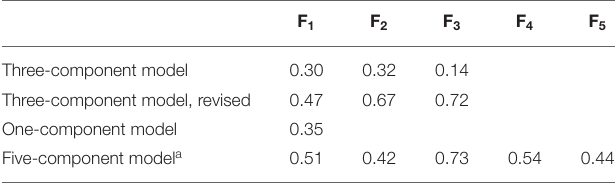
TABLE 7 | Variance explained by each factor for the respective CFA models.